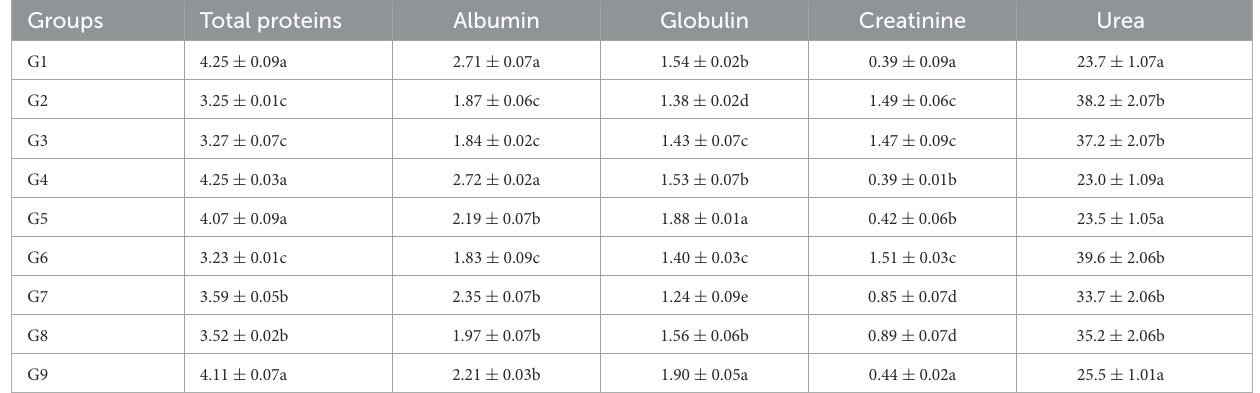
TABLE 5 Biochemical parameters (g/dL) of broiler chicks on day 42 experiment administered arsenic, chromium, vitamin E, and bentonite alone or in combination. Groups Total proteins